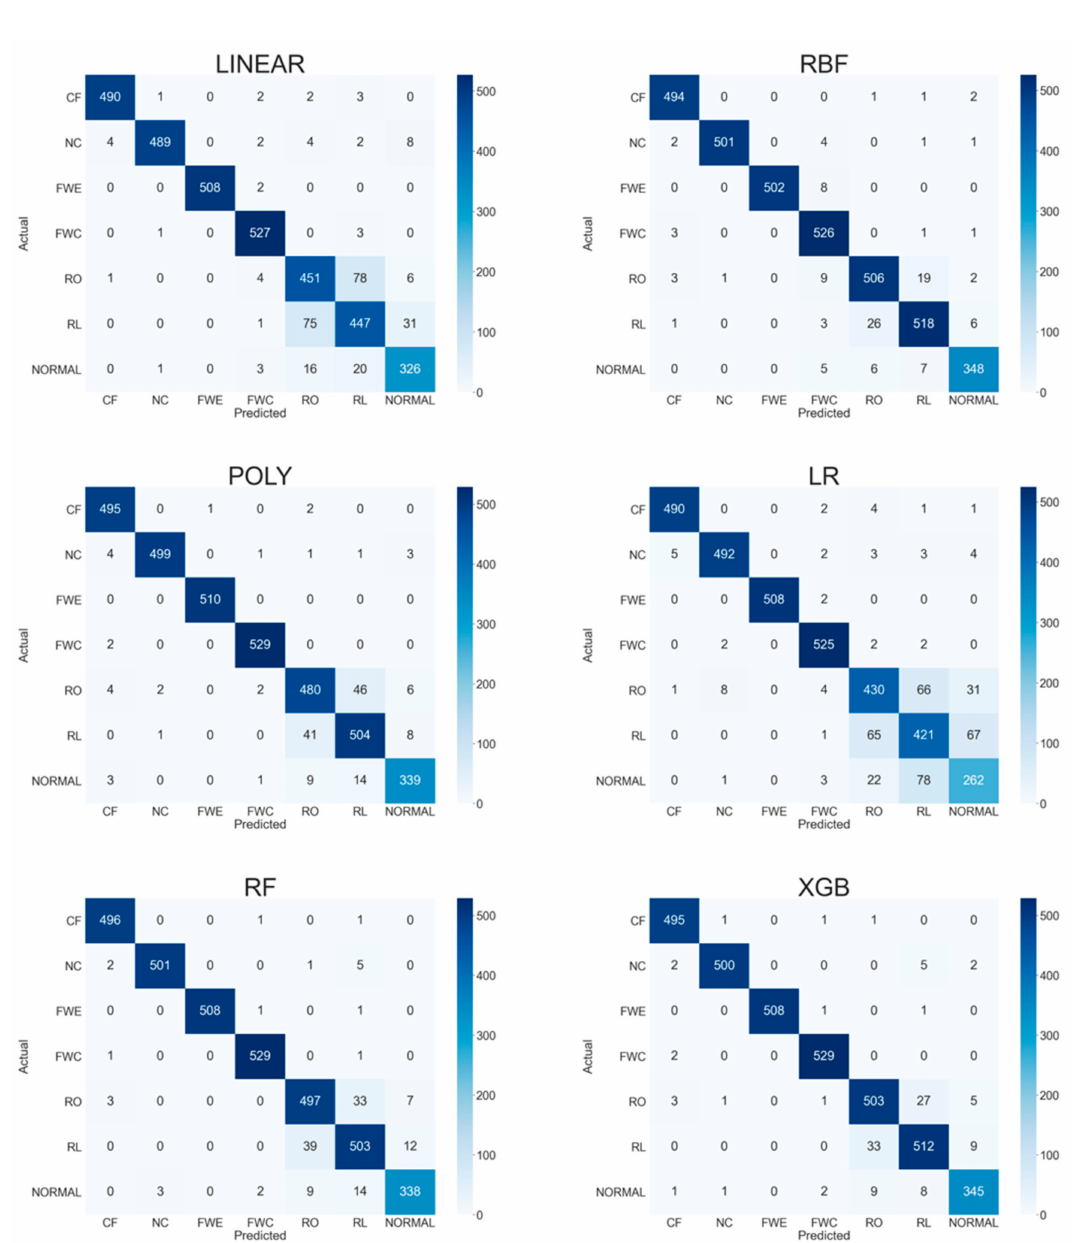
Figure 10. Confusion matrices for parameter-tuned classification methods (Case